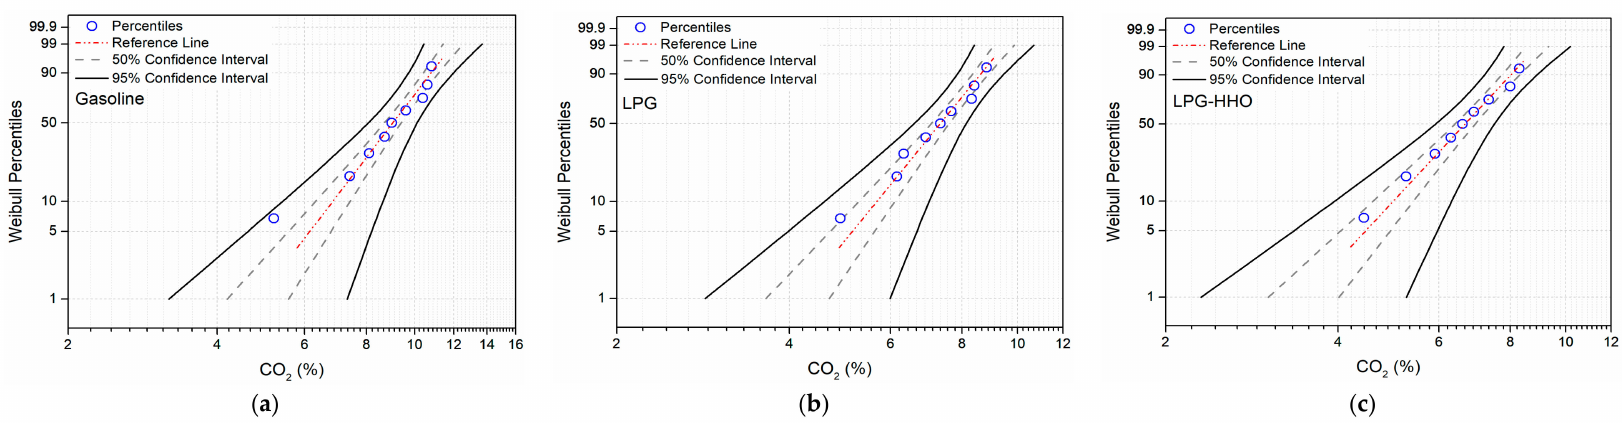
Figure 6. ( a – c ) Weibull probability plot of CO 2 for 50% and 95% CI using gasoline, LPG and LPG-HHO